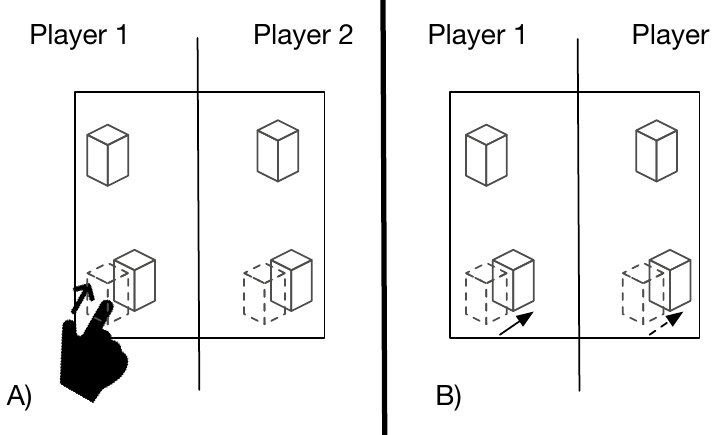
Figure 5. Speculation on actuated artifacts in dislocated boardgames: ( A ) player actuated: physical manipulation of a component on one player’s side and related actuation at other location; and ( B ) system actuated/automated: actuation of physical components based on digital enactment of rules by the